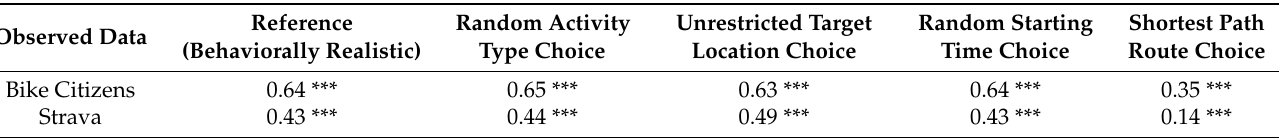
Table 7. Pearson’s correlation coefficients between the observed and simulated daily totals of cyclists on the network by scenario. Simulated data were compared with Bike Citizens and Strava